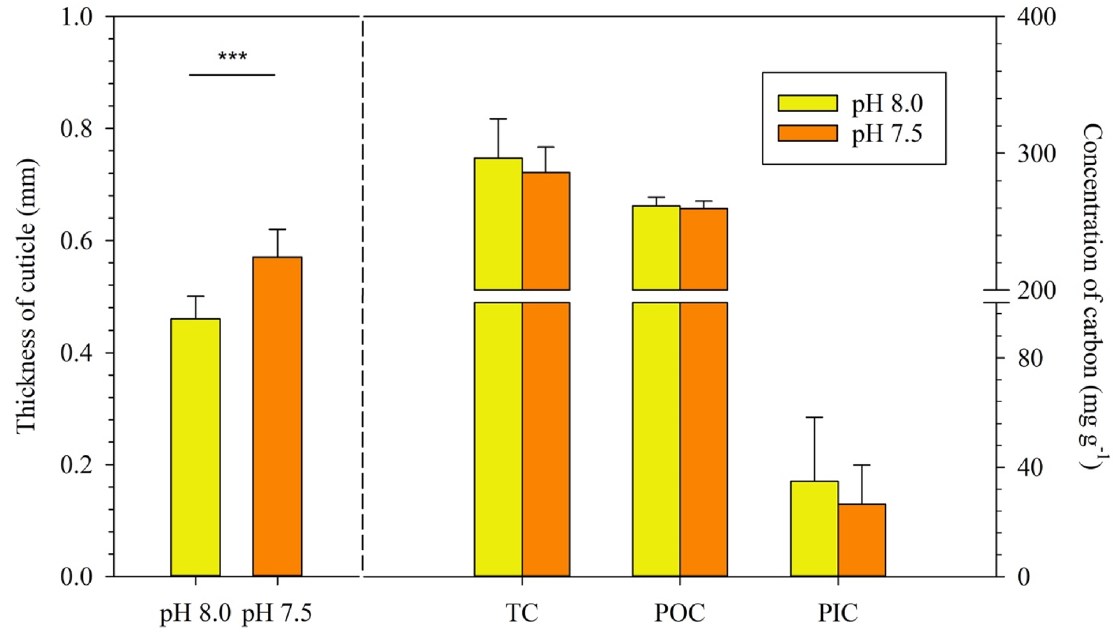
Figure 2. Thickness and carbon content of cuticle in pH 8.0 and pH 7.5 treatments. Left: Thickness of cuticle, where the height of each column represents mean ± S.E. (n = 30) and asterisks indicate a significant difference at p < 0.001. Right: Concentration of total carbon (TC), particulate organic carbon (POC) and particulate inorganic carbon (PIC) in shrimp cuticle, where column heights are means ± S.E (n = 6). No significant differences were found between the values of TC, POC or PIC measured in the pH 8.0 and pH 7.5